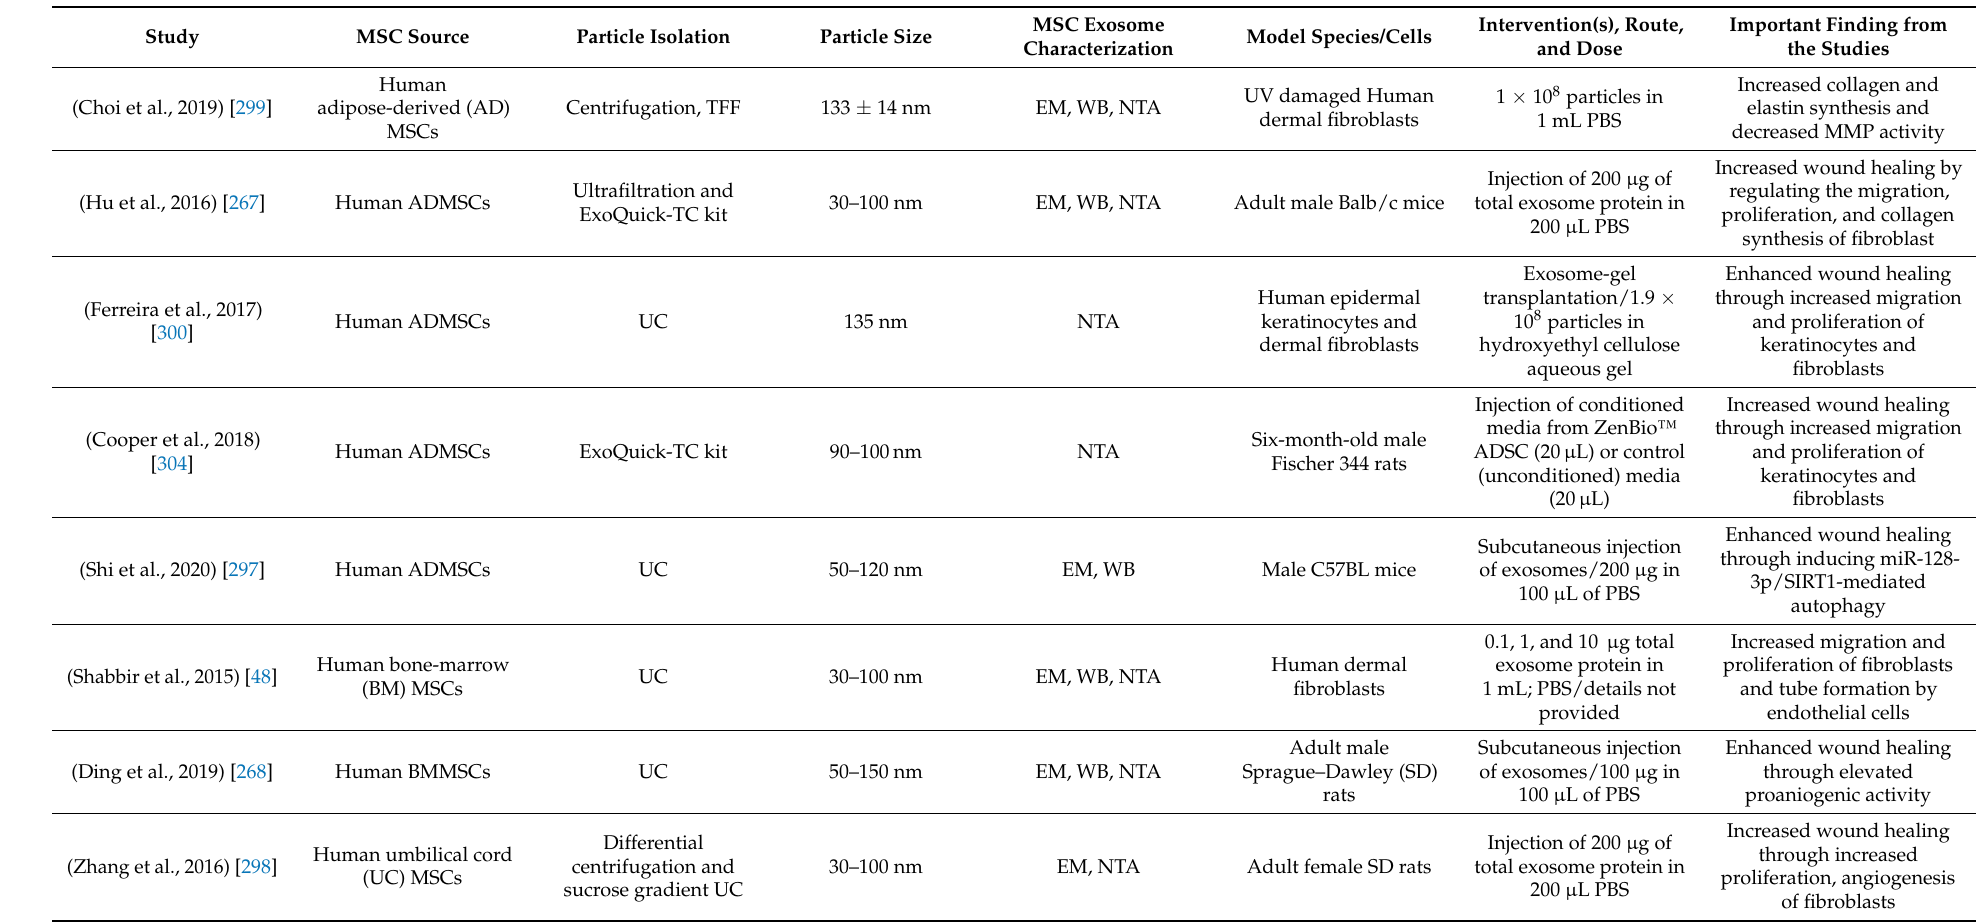
Table 8. MSC-derived exosomes in wound healing